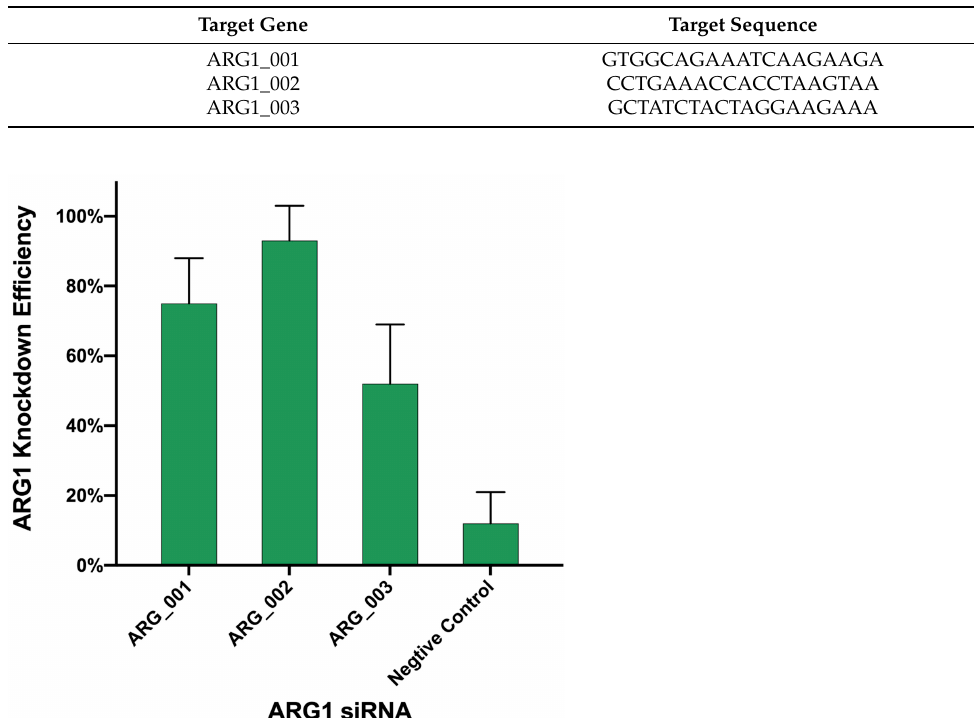
Table 2. The siRNA target sequence for the porcine ARG1 gene. Three siRNA targets were designed with the swine ARG1 gene (Accession number: XM_021082739).